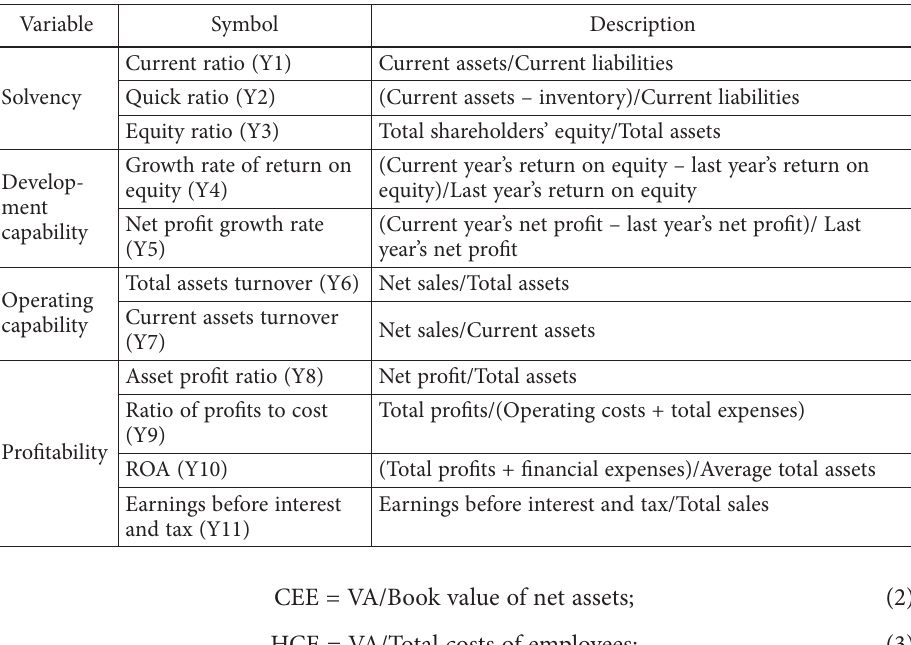
Table 1. FC evaluation index